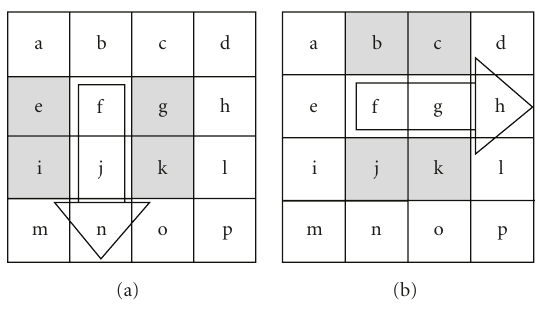
Figure 10: Gradient calculations.